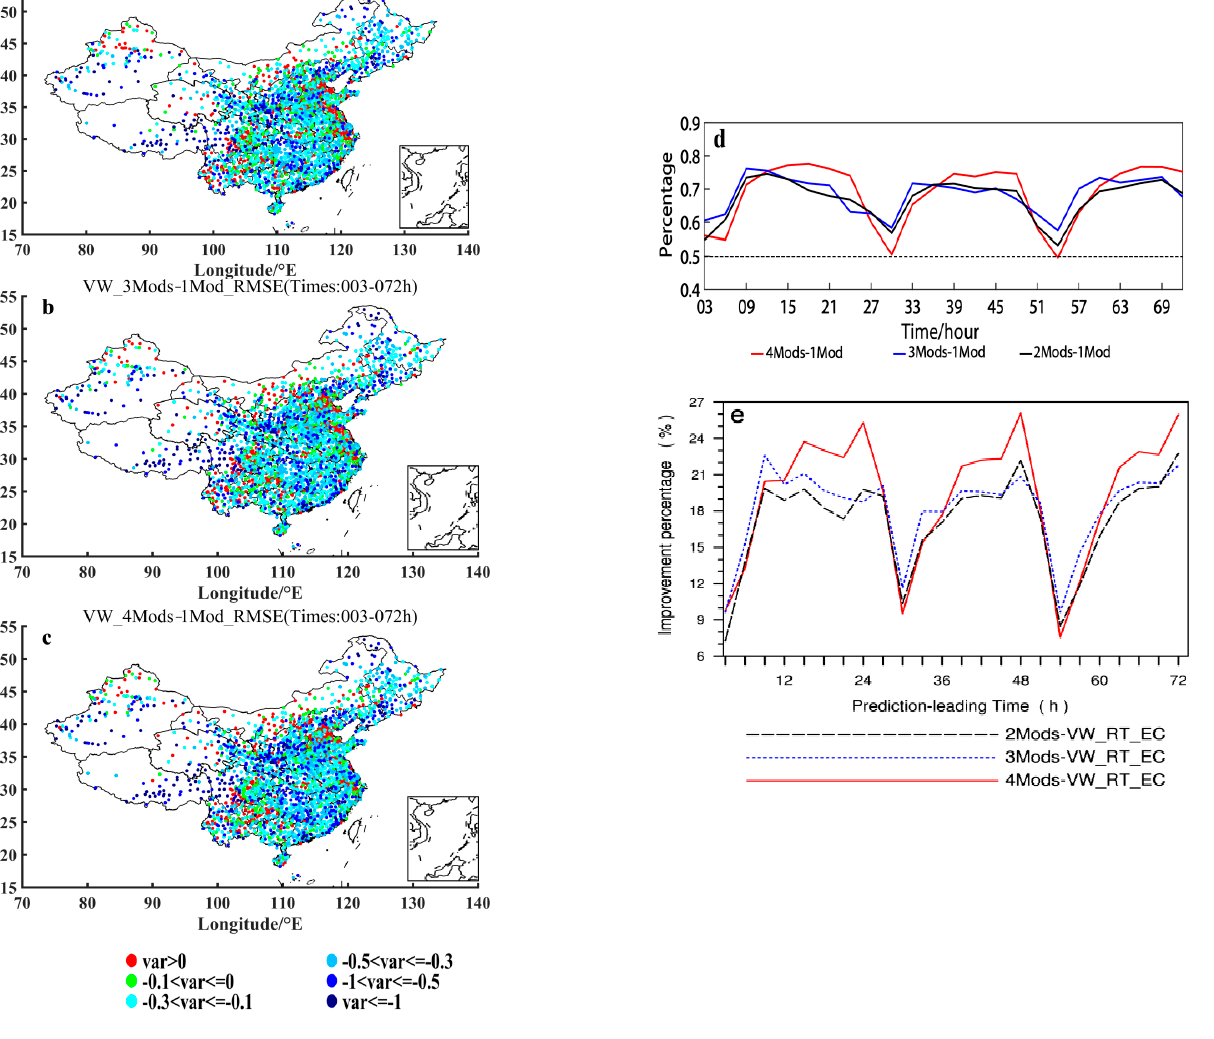
Figure 7. Distributions of the 2 m temperature prediction RMSEs differences (units: °C) between ( a ) 2 and 1, ( b ) 3 and 1, and (c) 4 and 1 models ensemble forecasting using the VW ensemble method. ( d ) Variations of the percentage of the stations, where negative (see the text for further details) 2 m temperature prediction RMSEs differences (units: °C) between 2 and 1 (2Mods-1Mod), 3 and 1 (3Mods-1Mod), and 4 and 1 (4Mods-1Mod) models ensemble forecasting using the VW ensemble method are shown, with respect to the prediction leading times. ( e ) Variation of improvement percentage of the 2-, 3- and 4-models ensemble forecasting using the VW method relative to the ECMWF forecasting, with respect to the leading times. The specific models taken for the 2-, 3- and 4-models ensemble forecasting are shown in Table 1, and the 1 model indicates the ECMWF